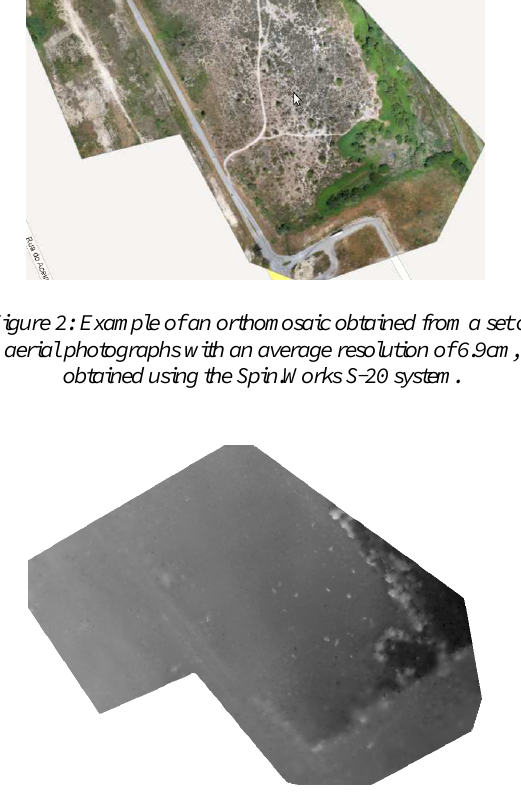
Figure 3: Example of a Digital Surface Map resulting from the same set of aerial photographs as in Figure 2.